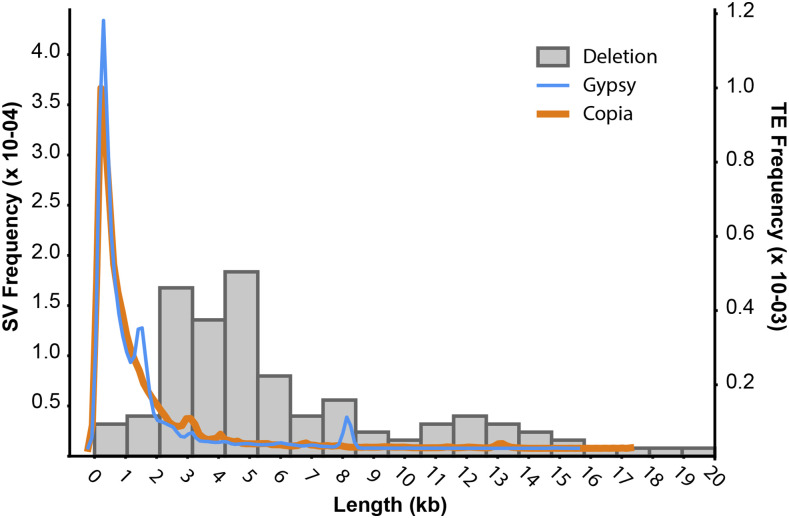
Length distribution of deletions in ME034V assembly compared to average size of common transposable elements. Histogram of length distributions of predicted deletions (gray bars) overlapped by density plots depicting the size distribution of annotated copia (orange) and gypsy (blue) retrotransposons in the ME034V assembly.